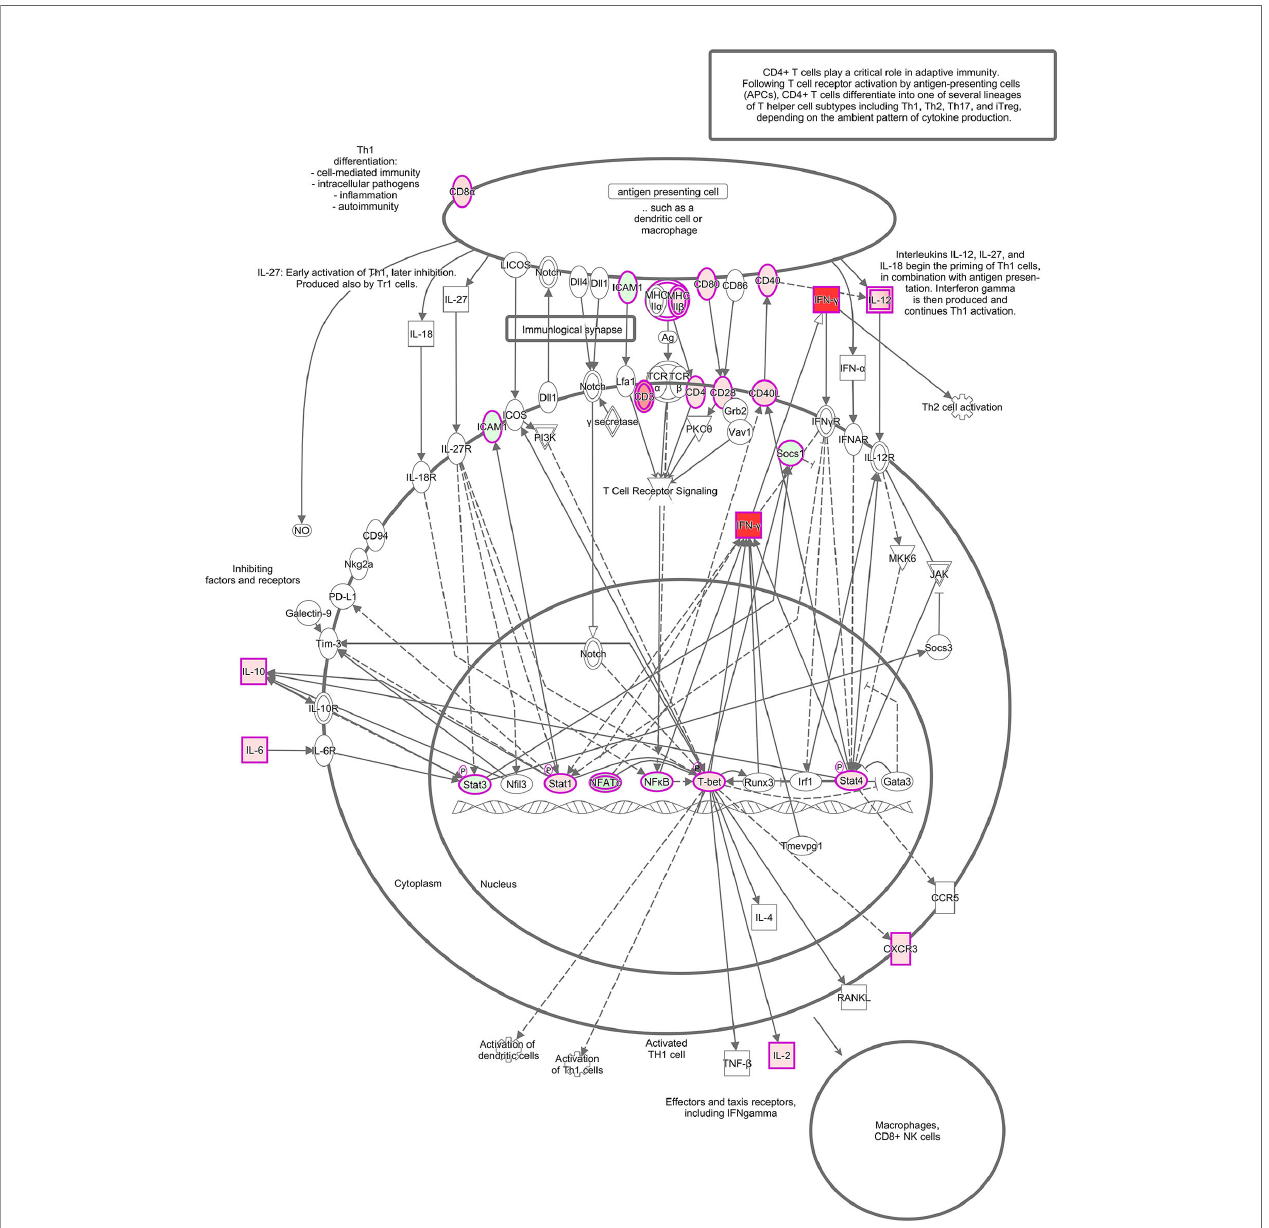
FIGURE 4 | Th1 activation pathway representation. In silico analysis done using IPA software (QIAGEN, USA) showing a signaling pathway built with: IFN- g , CD3, CD4, CD8 a , CD28, CD40, CD40L, CD80, ICAM1, CXCR3, MHCII b , IL-12, IL-10, IL-6, IL-2, Socs1, Stat1, Stat3, Stat4, NFAT ϵ , NF k B, and T-bet. The molecules are highlighted with fuschia/pink outlines and fi lled with different shades of red or green color which indicate up and down-regulation, respectively, based on their fold change values from the infected group compared to the non-infected group. Direct line: direct activation; dashed line: indirect